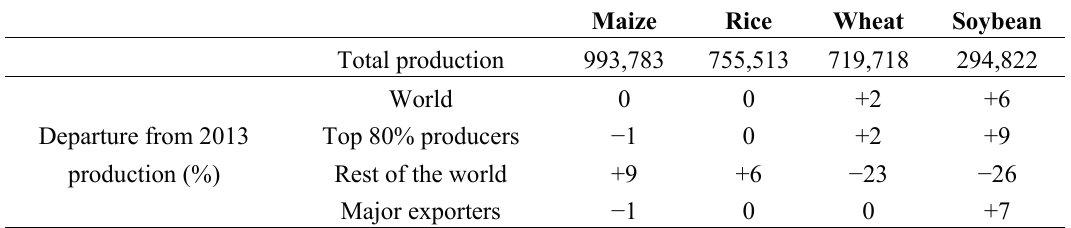
Table 3. Global 2014 production of maize, rice, wheat, and soybean (thousand tons) and departure from 2013 production (estimates issued in the November 2014 CropWatch